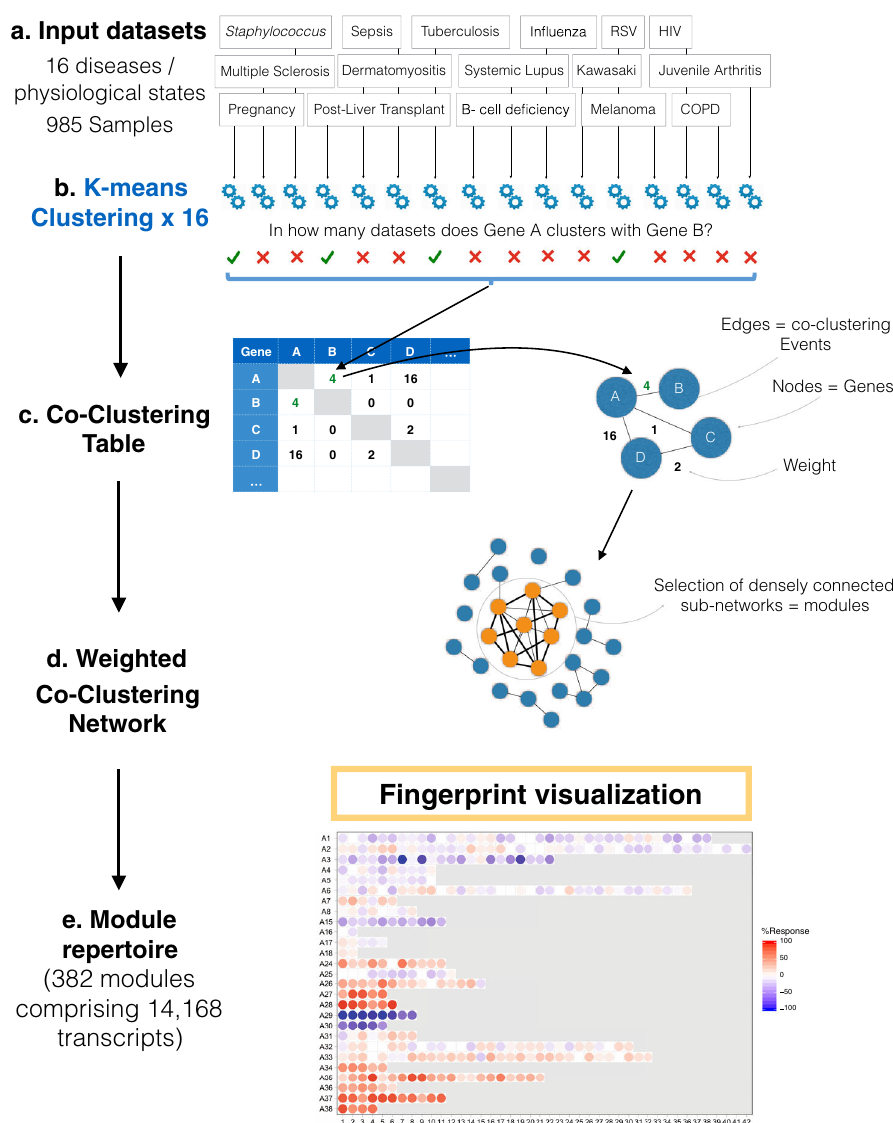
Fig. 1 The module repertoire construction process. a A collection of 16 blood transcriptome datasets spanning a wide range of immunological and physiological states was used as a starting point for the identi fi cation of gene co-expression patterns (RSV: Respiratory Syncytial Virus, HIV: Human Immunode fi ciency Virus, COPD: Chronic Obstructive Pulmonary Disease). b Each dataset was independently clustered via k-means clustering. c Gene co- clustering events were recorded in a table, where the entries indicate in how many datasets, out of the 16, co-clustering was observed for a given gene pair. d The co-clustering table served as the input to build a weighted co-clustering graph (see also Supplementary Fig. 1), where the nodes represent genes and the edges represent co-clustering events. e The largest, most highly weighted sub-networks among a large network (constituting 15,132 nodes in this case) were identi fi ed mathematically and assigned a module ID. The genes constituting this module were removed from the selection pool and the process was repeated to select the next largest set of genes. Once all the gene sets for a given round of selection have been identi fi ed the criterion is relaxed for the next round, (e.g. M1 modules corresponding to the fi rst round with the highest co-clustering weight [16 out of 16 datasets], M2 modules corresponding to the second round [co-clustering observed in 15 out of 16 datasets]). Overall, this process resulted in the selection of 382 modules comprising 14,168